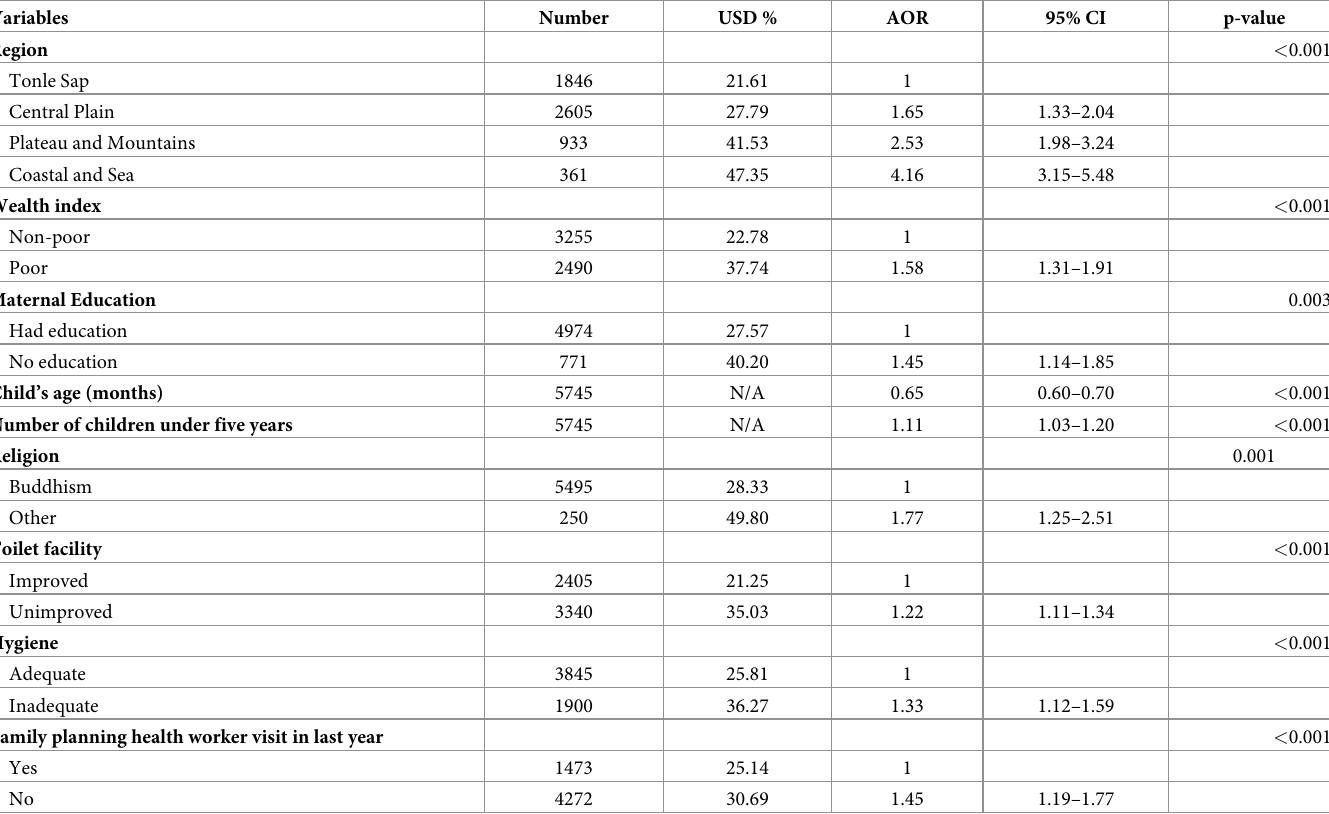
Table 3. Multivariable analysis of factors associated with unhygienic stool disposal (USD) of children under the age of five in Cambodia, (n =